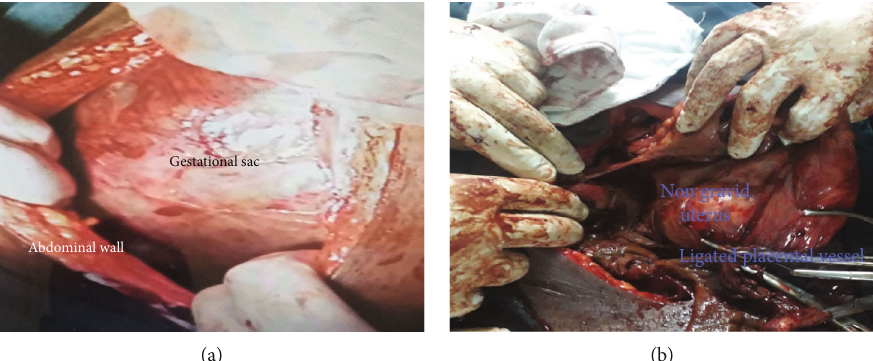
Figure 2: (a and b) Intraoperative fi ndings showing gestational sac with the peritoneal cavity, nongravid sized uterus, and meconium- stained bowel.